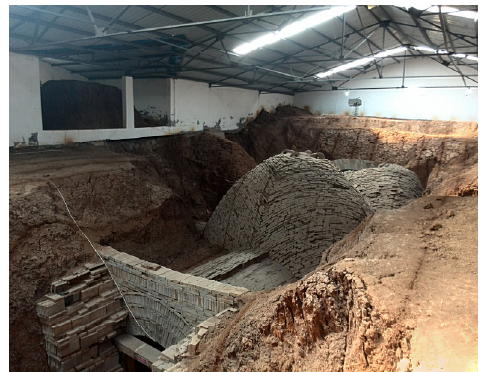
Figure 1. The Eastern Wu tomb in the protective shed.